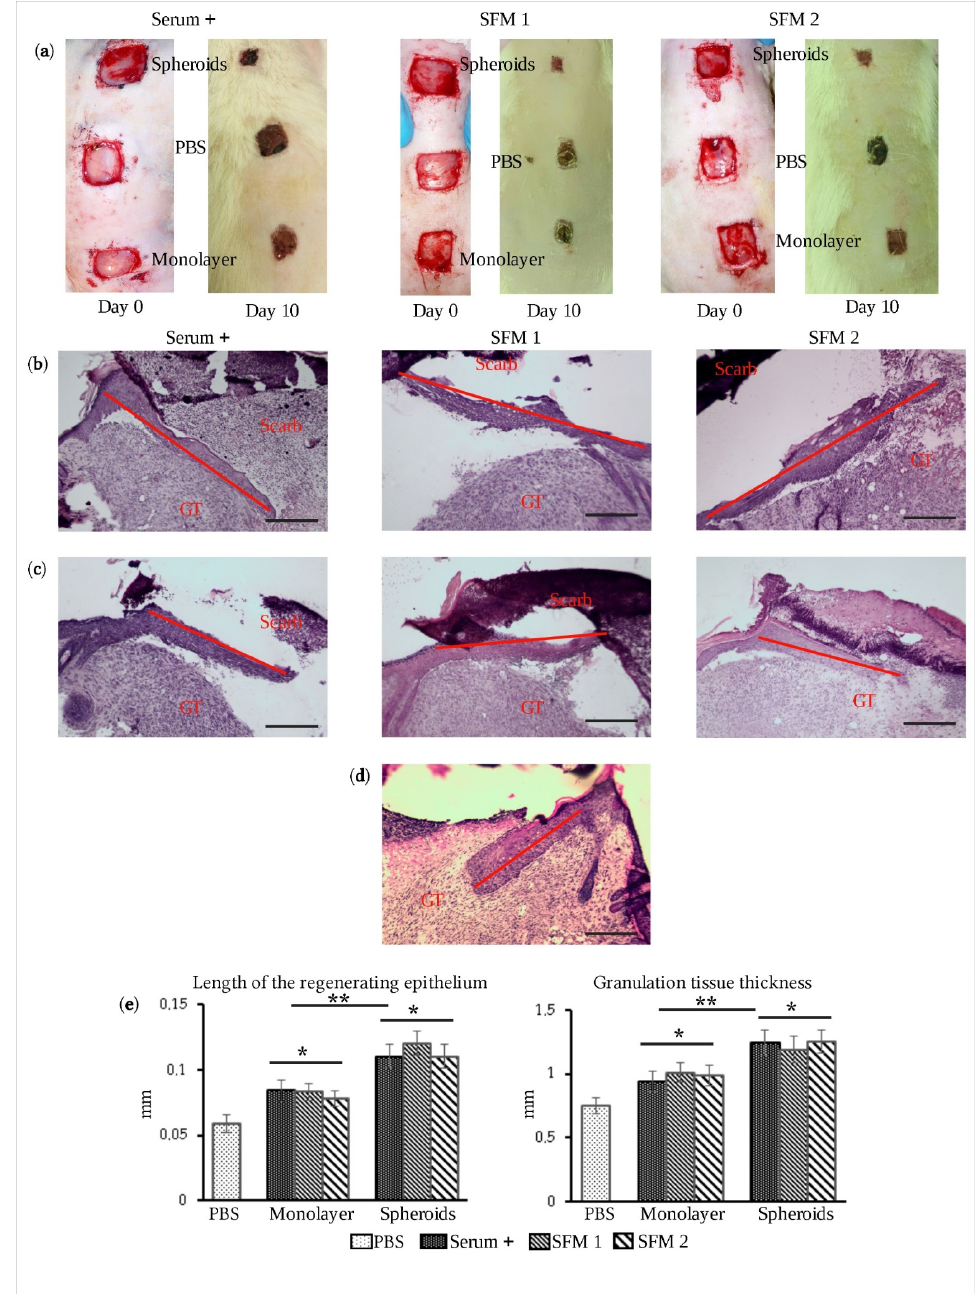
Figure 3. Therapeutic efficacy of eMSC spheroids in serum-free medium. ( a ) Macroscopic view of the wound closure in rat after transplantation of eMSCs in spheroids cultured in serum-containing medium (Serum+), SFM 1 or SFM 2, eMSCs cultured in monolayer at the same conditions and PBS as a control; ( b ) H&E staining of paraffin-embedded tissue section of rat wounds on the 7th day after transplantation of eMSCs in spheroids (scale bar, 100 µ m). GT—granulation tissue, line—regenerating epithelium. ( c ) H&E staining of paraffin-embedded tissue section of rat wounds on the 7th day after transplantation of eMSCs cultured in monolayer (scale bar, 100 µ m). GT—granulation tissue, line—regenerating epithelium. ( d ) H&E staining of paraffin-embedded tissue section of rat wounds on the 7th day after PBS injection (scale bar, 100 µ m). GT—granulation tissue, line—regenerating epithelium. ( e ) Recovery of granulation and epithelium tissues in rat wound after eMSC transplantation. Data are shown as mean ± SD ( n = 15). The differences in recovery of granulation and epithelium tissues in rat wounds were tested by the Kruskal–Wallis H-test (non-parametric ANOVA) followed by post hoc pairwise comparison using Dunn’s test. * p < 0.05 vs. PBS control; ** p < 0.05 vs. monolayer culture at the same